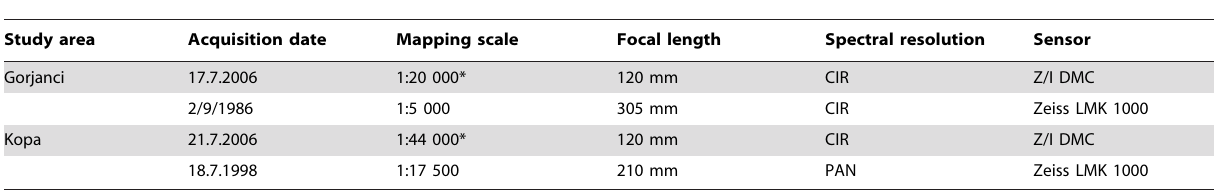
(*) Mapping scale estimate based on the digital mapping camera (DMC) from Z/I Imaging with 12 m m pixel size and 25 cm to 50 cm ground sample distance (GSD). For 2009 the UltraCamXp Vexcel Imaging camera was used (orthoimages with GSD of 25 cm).